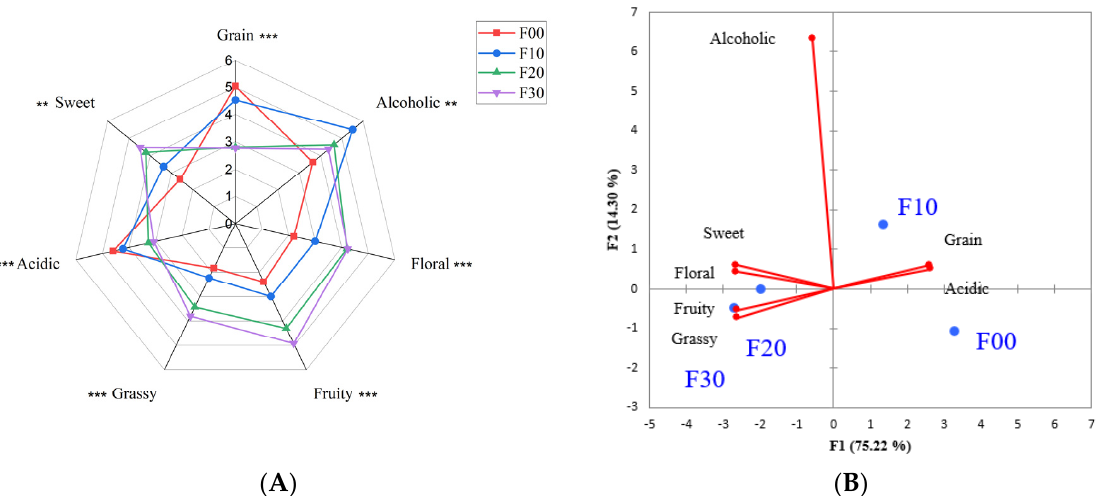
Figure 3. ( A ) Aroma profile of the mean sensory scores of the four different grades of FJ. Notations: “ ** and “ *** ” indicate significance at p < 0.01 and p < 0.001, respectively. ( B ) PCA score plot based on the sensory scores.